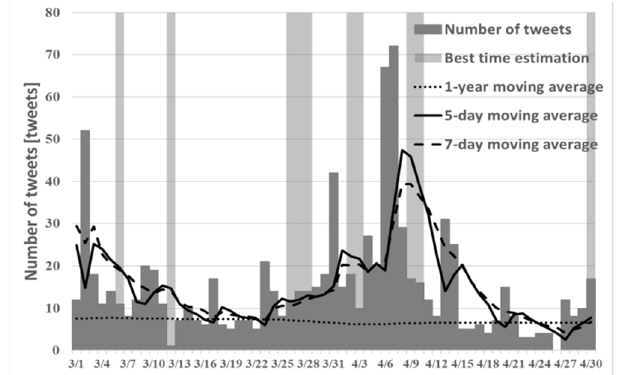
Figure 4. Shizuoka in 2019.